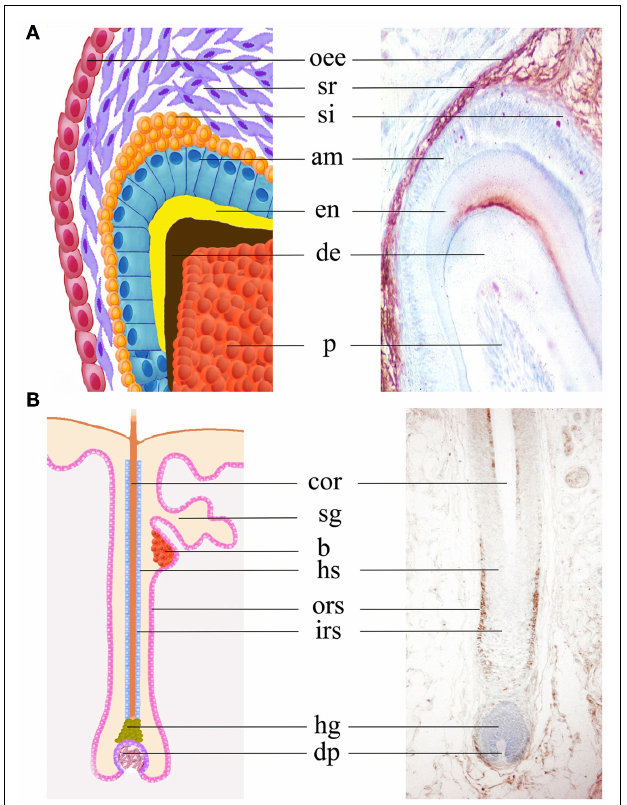
FIGURE 7 | Expression of the Notch2 protein in molar teeth and hair follicles. Immunohistochemical staining (brown color) on sections shows Notch2 expression in stellate reticulum, stratum intermedium, outer enamel epithelium, and dental papilla in postnatal day 6 mouse molars (A) . In human hair follicles, Notch2 protein is mainly detected in outer root sheath (B) . Abbreviations: am, ameloblast; b, bulge; cor, cortex; de, dentin; dp, derma papilla; en, enamel; irs, inner root sheath; hg, hair germ; hs, hair sheath; oee, outer enamel epithelium; ors, outer root sheath; p, pulp;